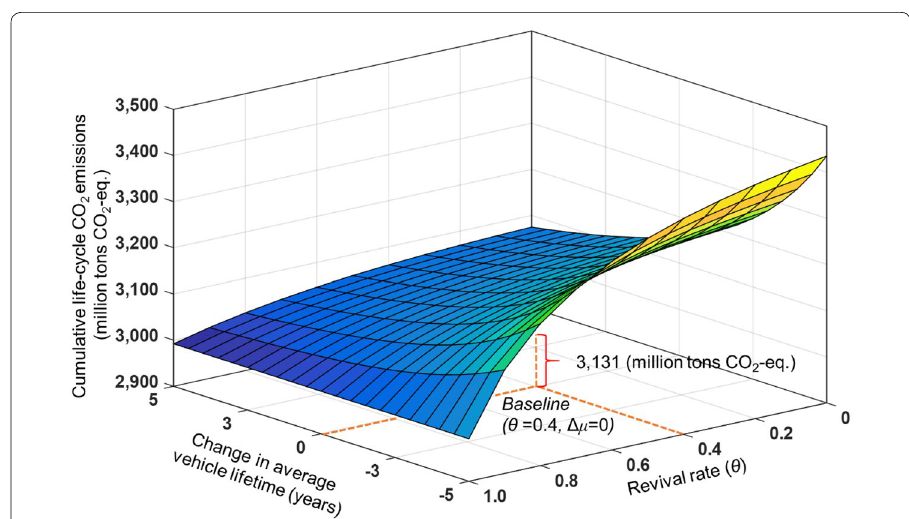
Fig. 5 Cumulative life-cycle CO 2 emissions of new and used cars registered during 1993–2013 under com- bined scenarios of average vehicle lifetime and revival